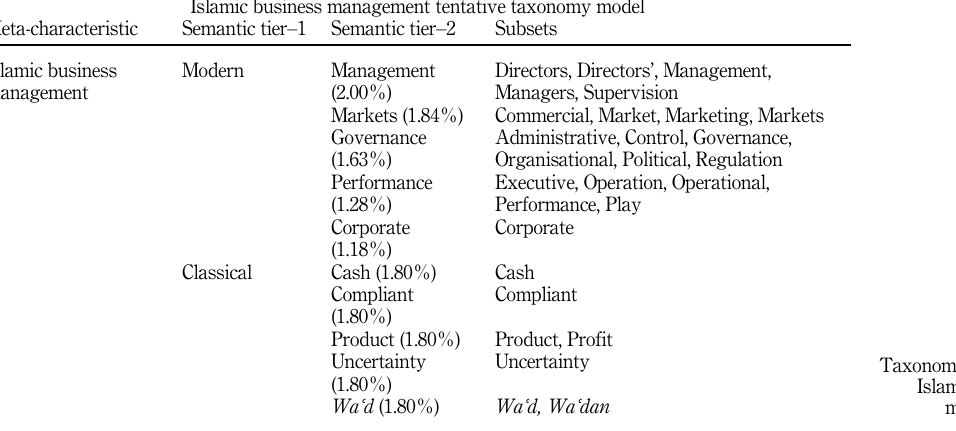
Table 4. Taxonomy model